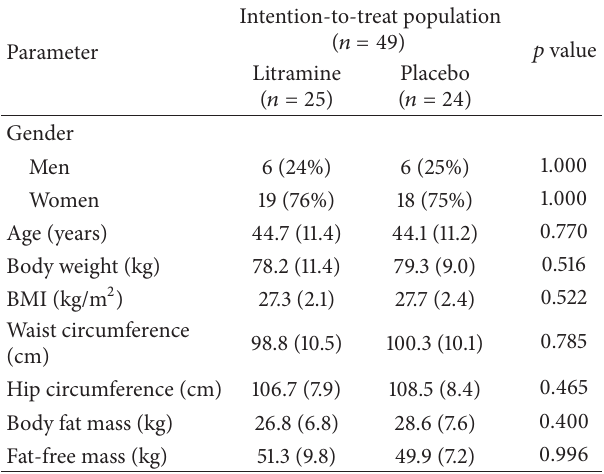
Table 1: Baseline characteristics of intention-to-treat population. Values are presented as mean (standard deviation) unless otherwise specified.